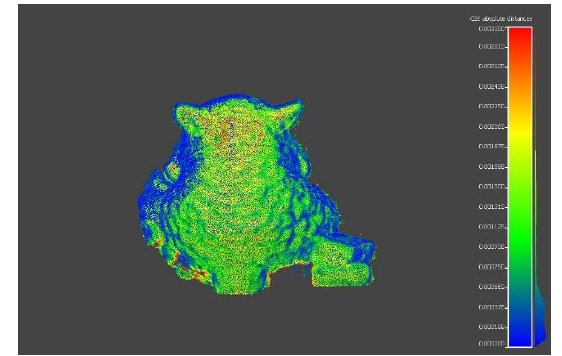
Figure 17: Point cloud comparison (rear part of the